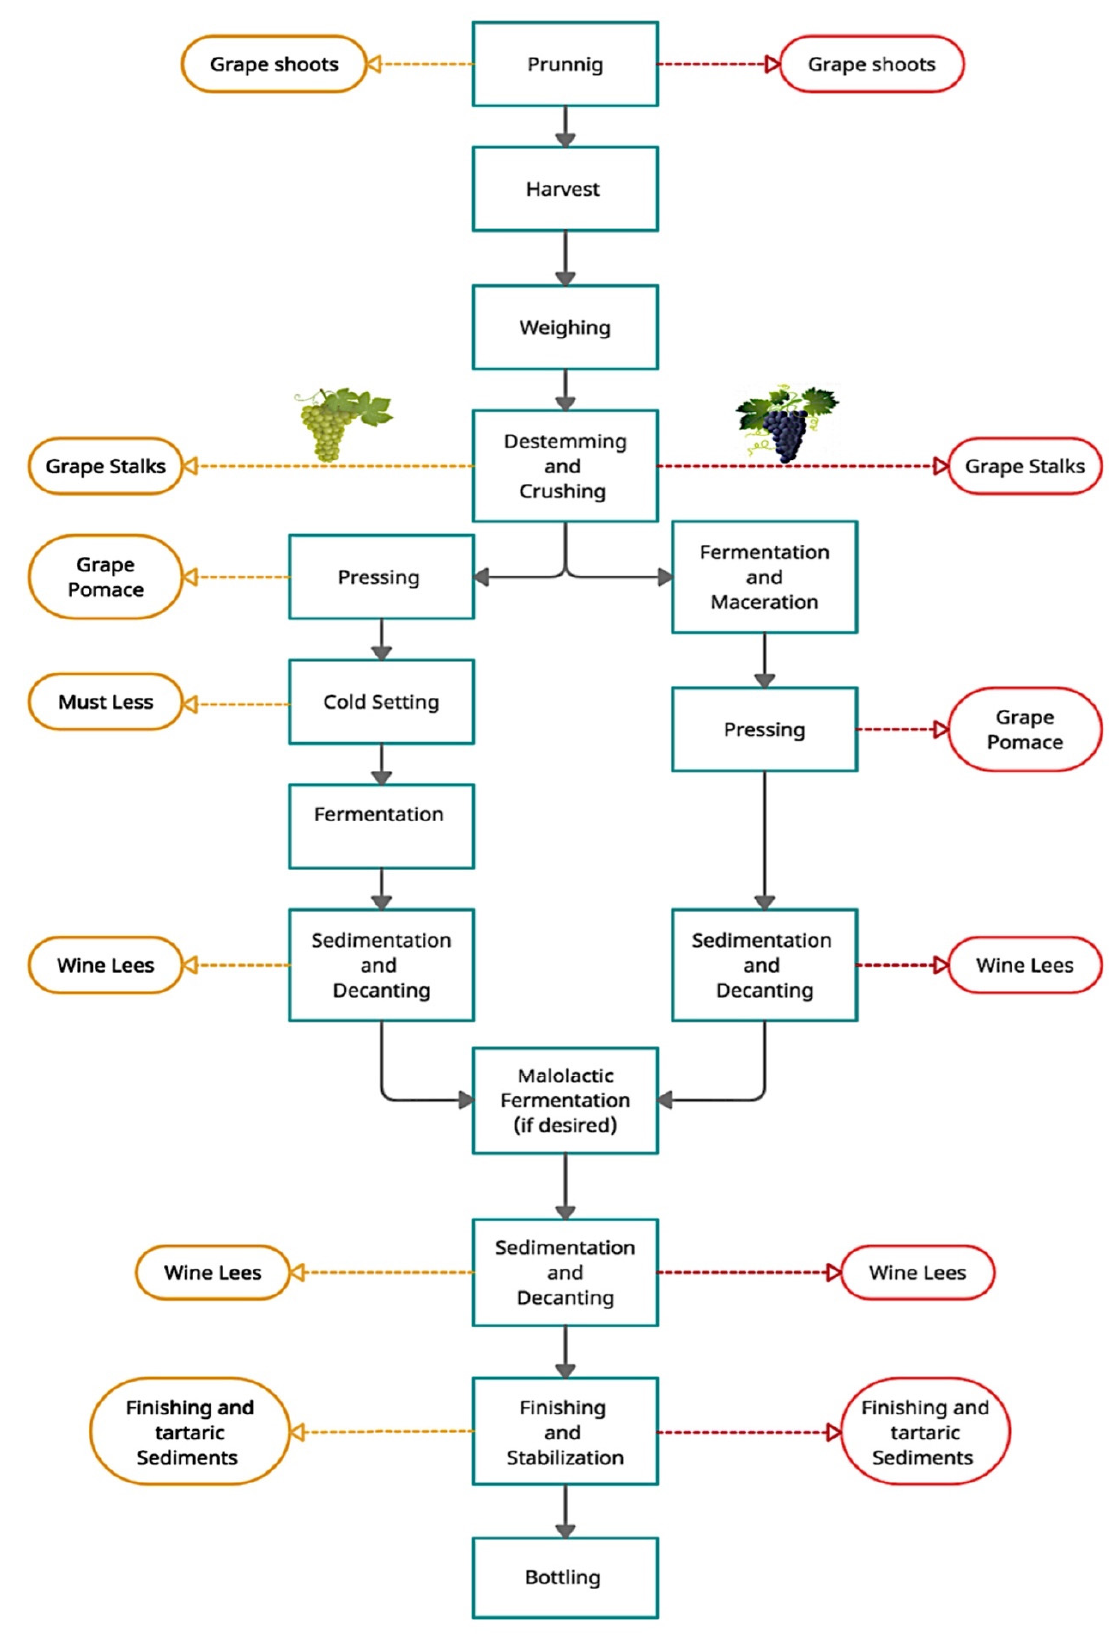
Figure 1. Schematic diagram of waste generation during wine production.